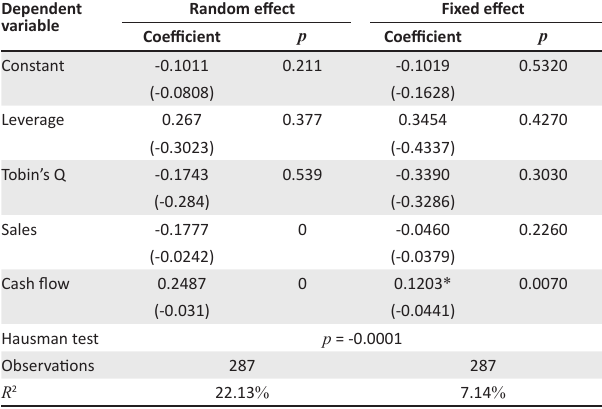
TABLE 7: Regression results for Equation (1) based on a subsample of firms with low growth opportunities. Dependent variable